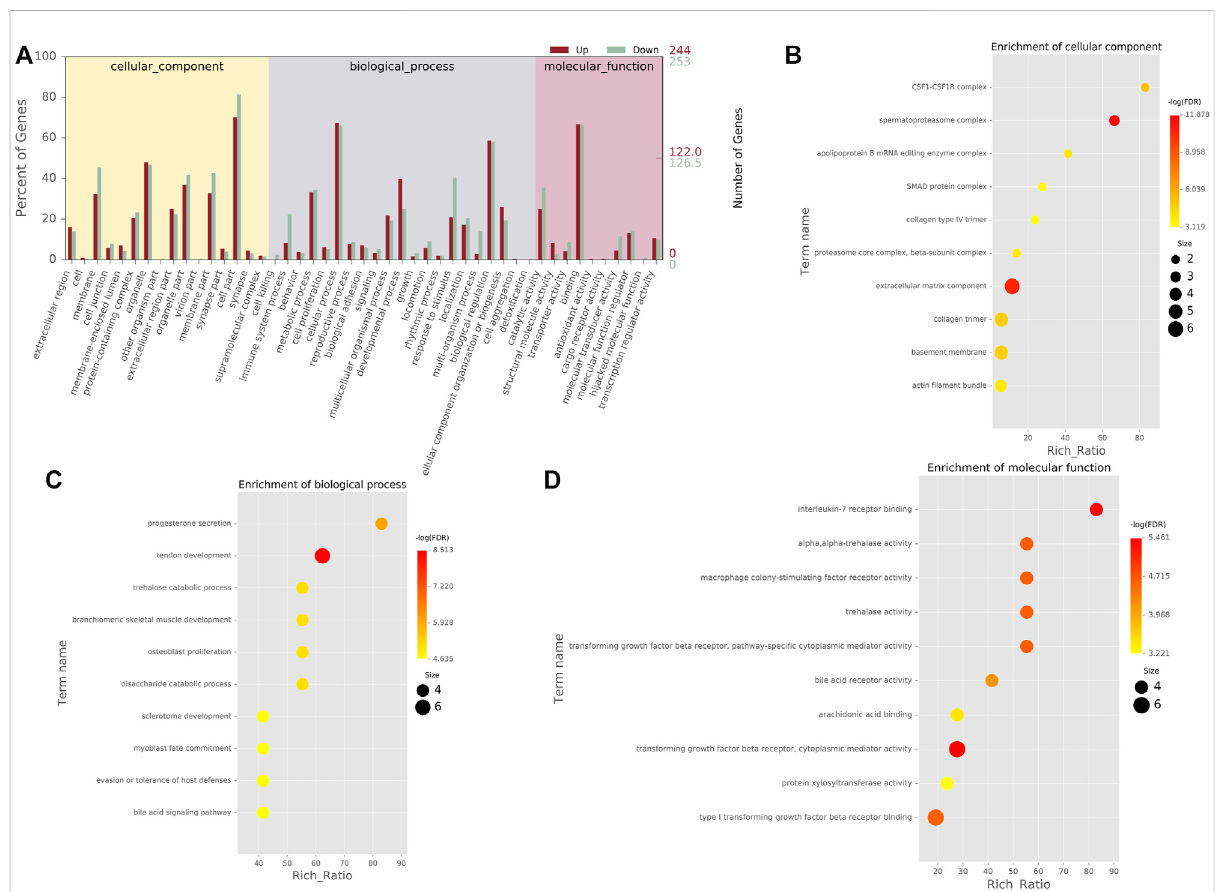
FIGURE 3 GO classi fi cation and enrichment analyses of DEGs (A) . GO classi fi cation of DEGs. The x -axis indicated the subcategories, the left y -axis represented the percentage of a speci fi c category of DEGs, and the right y -axis indicated the number of DEGs (B) . Top 10 cellular component